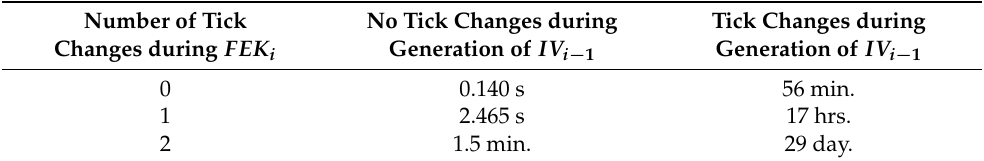
Table 3. Experimental results of file encryption key ( FEK )